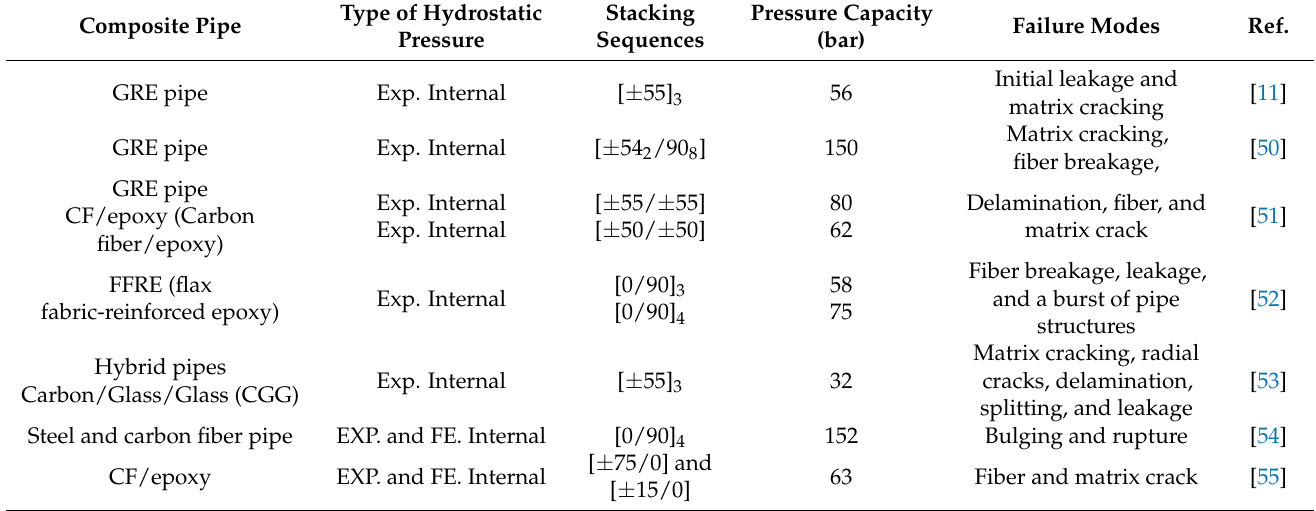
Table 2. Composite pipes subjected to internal and external hydrostatic with various parameters and